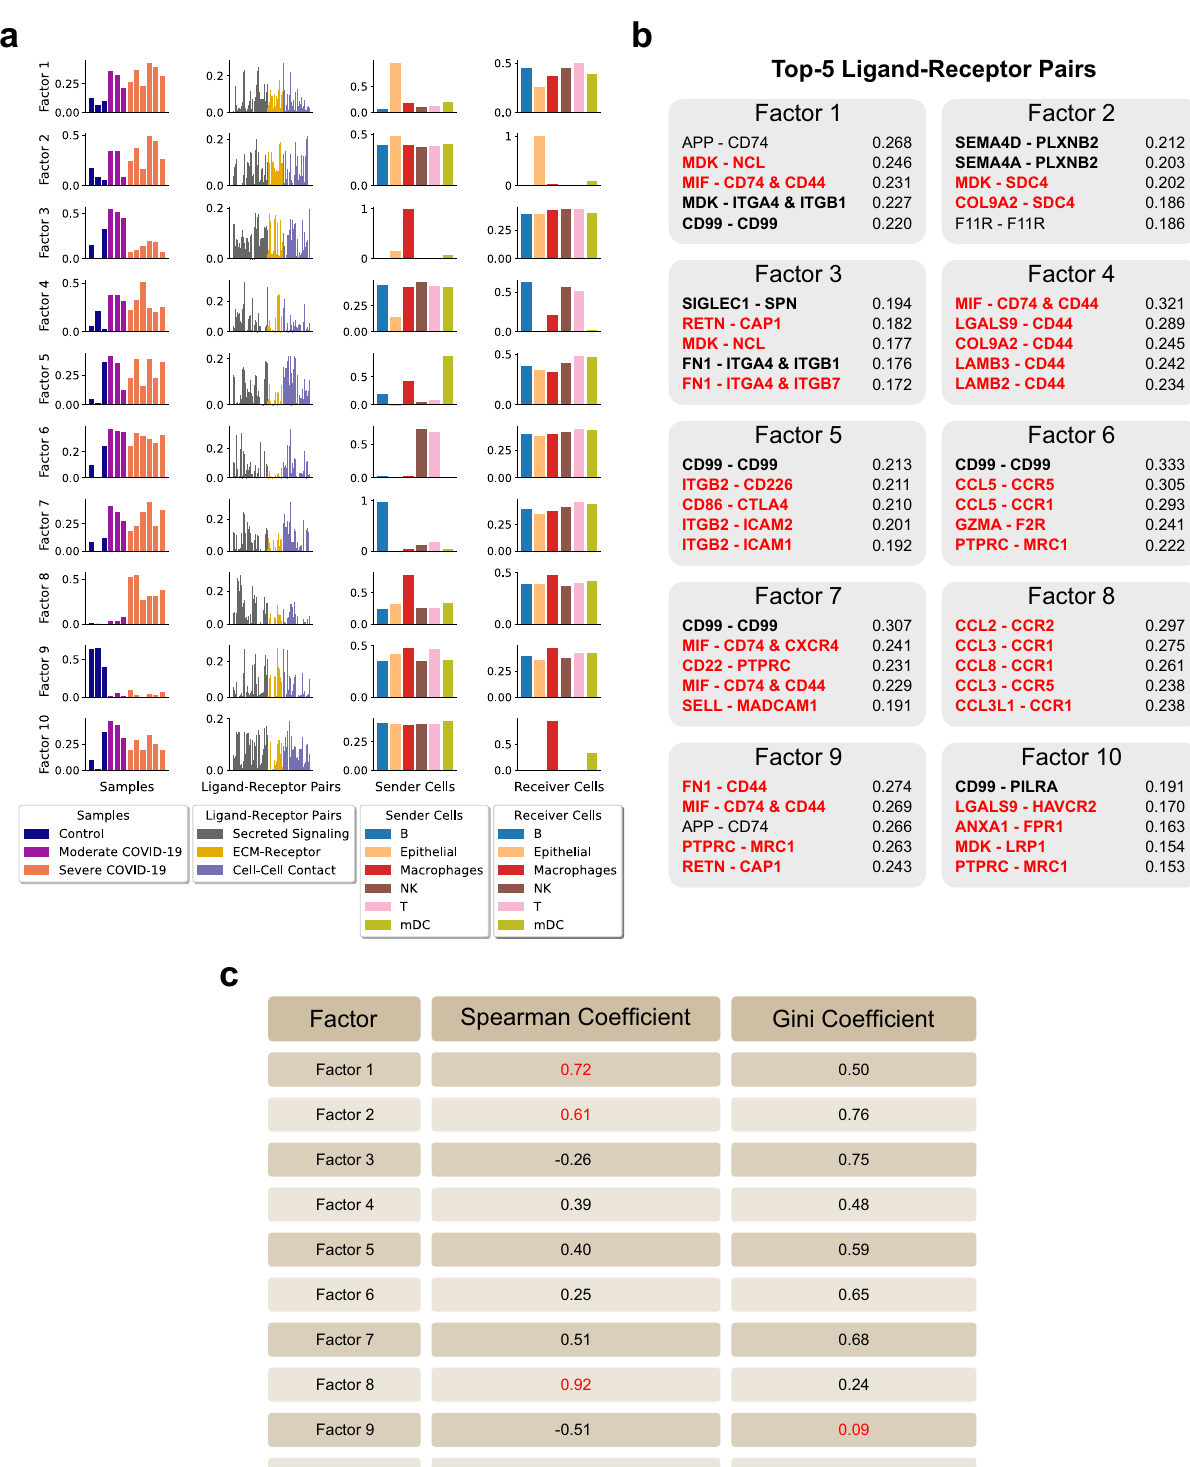
(Fig. 4a). For example, we found interactions that are character- istic of severe (factor 8) and moderate COVID-19 (factors 3